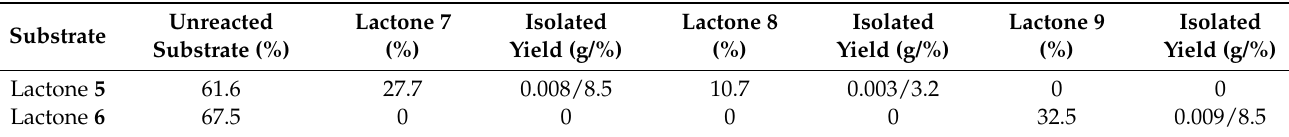
Table 2. Results obtained from preparative scale biotransformation of lactones 5 and 6 by A. cylindrospora AM336 after 7 days of incubation (in percentage according to GC).